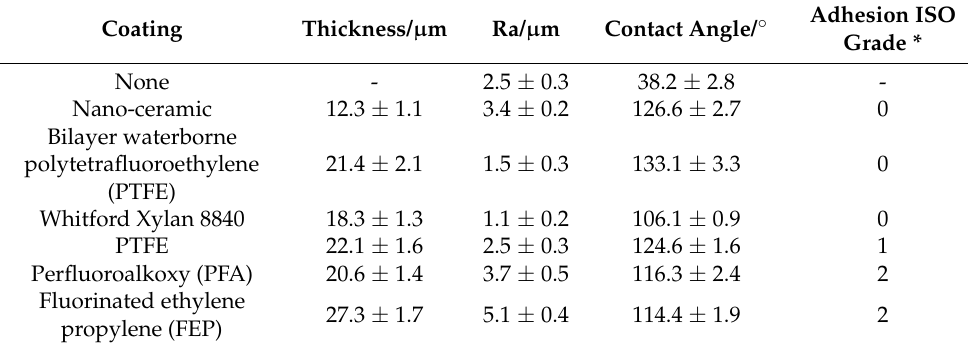
Adhesion ISO Grade *